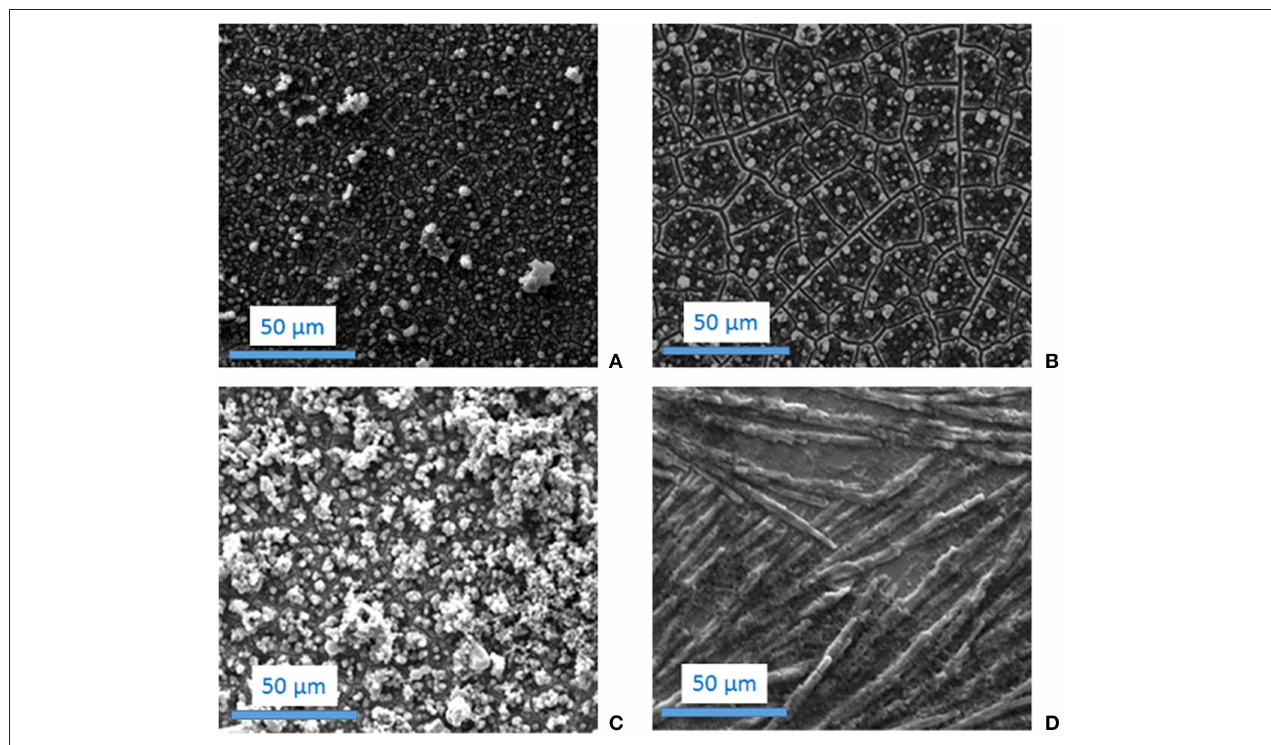
FIGURE 5 | SEM images of the films obtained by electrodeposition of 10 − 2 M: Cz (A) , CzA (B) , CzV (C) and CzE (D) in 0.1M LiClO 4 + acetonitrile.